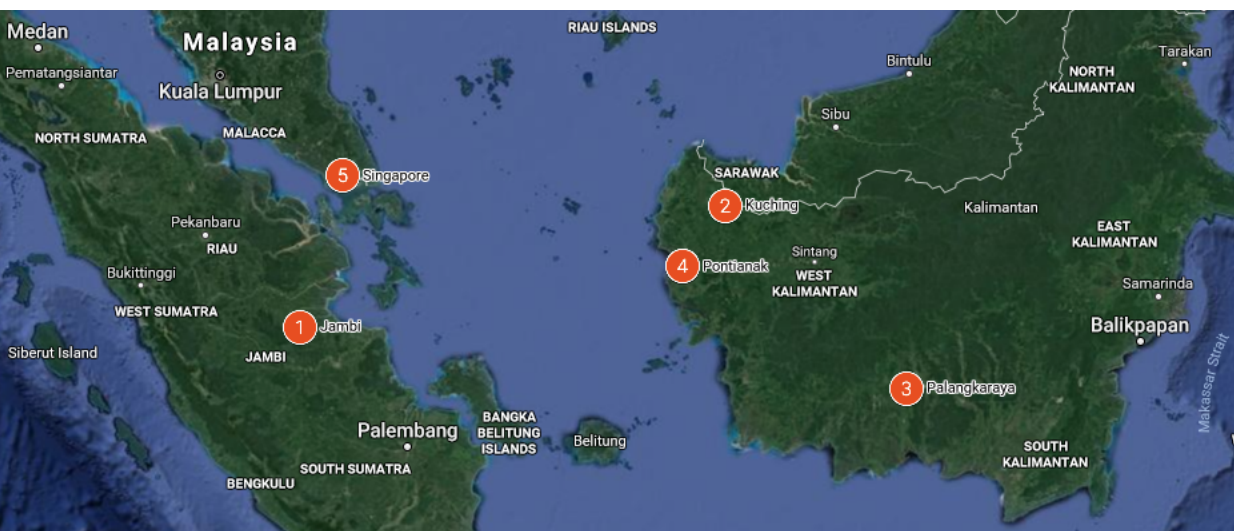
Figure 1. Locations of the five AERONET sites that are used in this study from Google Maps. 1: Jambi ( − 1 ◦ N, 103 ◦ E); 2: Kuching (1 ◦ N, 110 ◦ E); 3: Palangkaraya ( − 2 ◦ N, 113 ◦ E); 4: Pontianak (0 ◦ N, 109 ◦ E); and 5: Singapore (1 ◦ N, 103 ◦